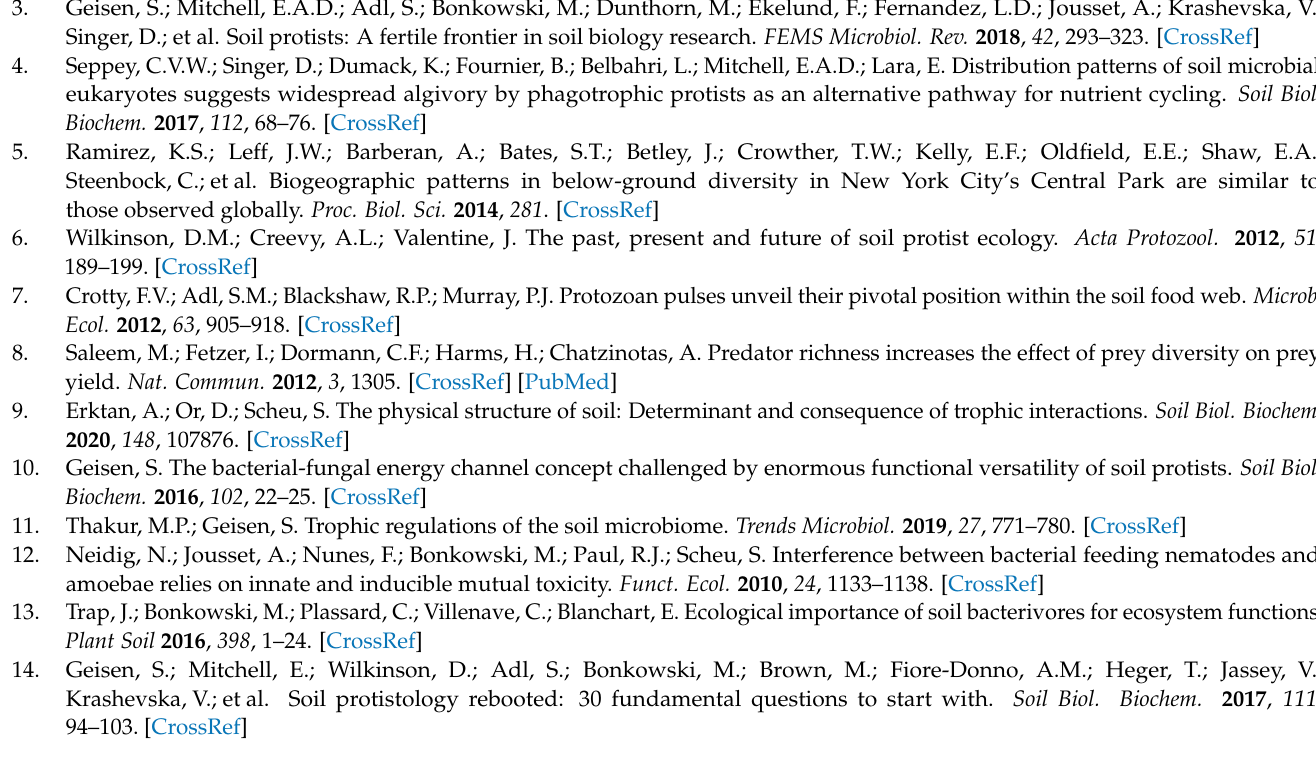
results, Table S2: Network taxon names, Table S3: MANOVA results, Table S4: Palatability Index, and Table S5: Kendall’s Tau test